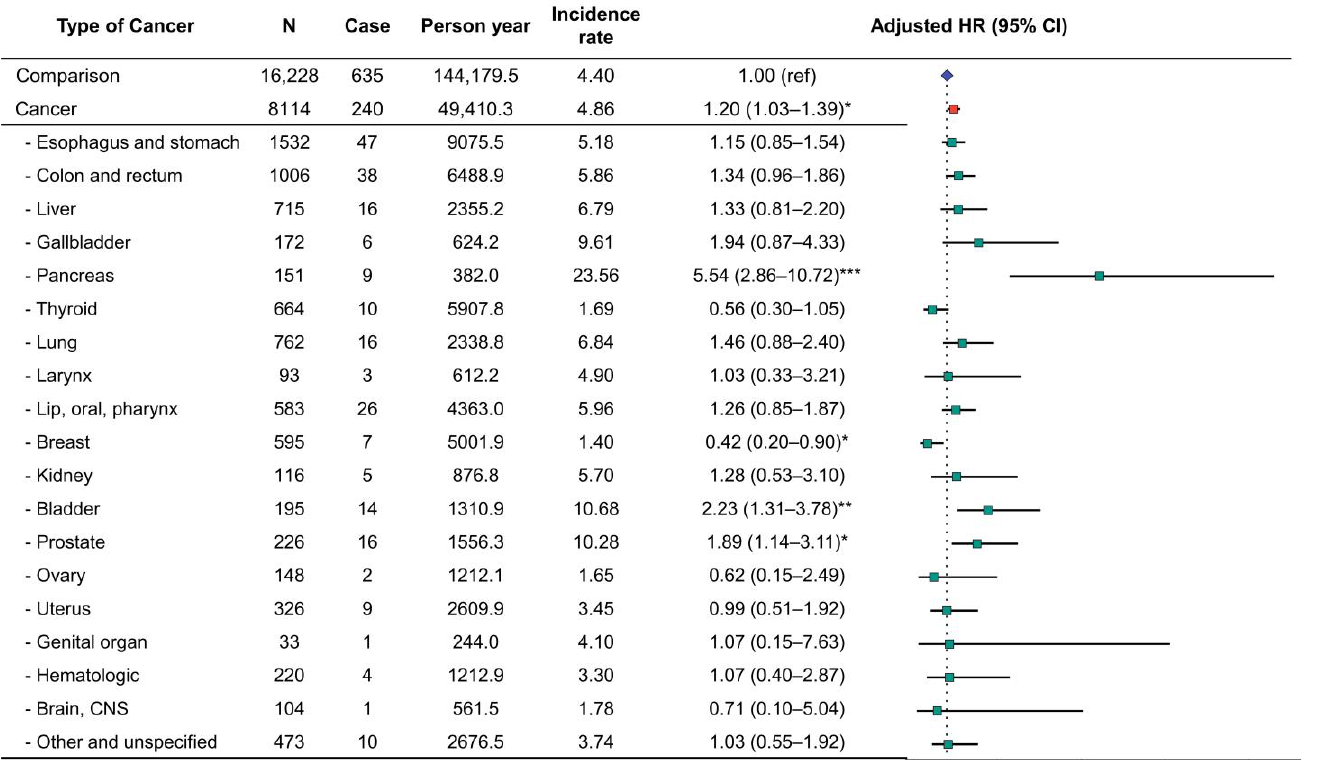
patients with type 2 diabetes by cancer type. * p < 0.05, ** p < 0.010, and *** p < 0.001.